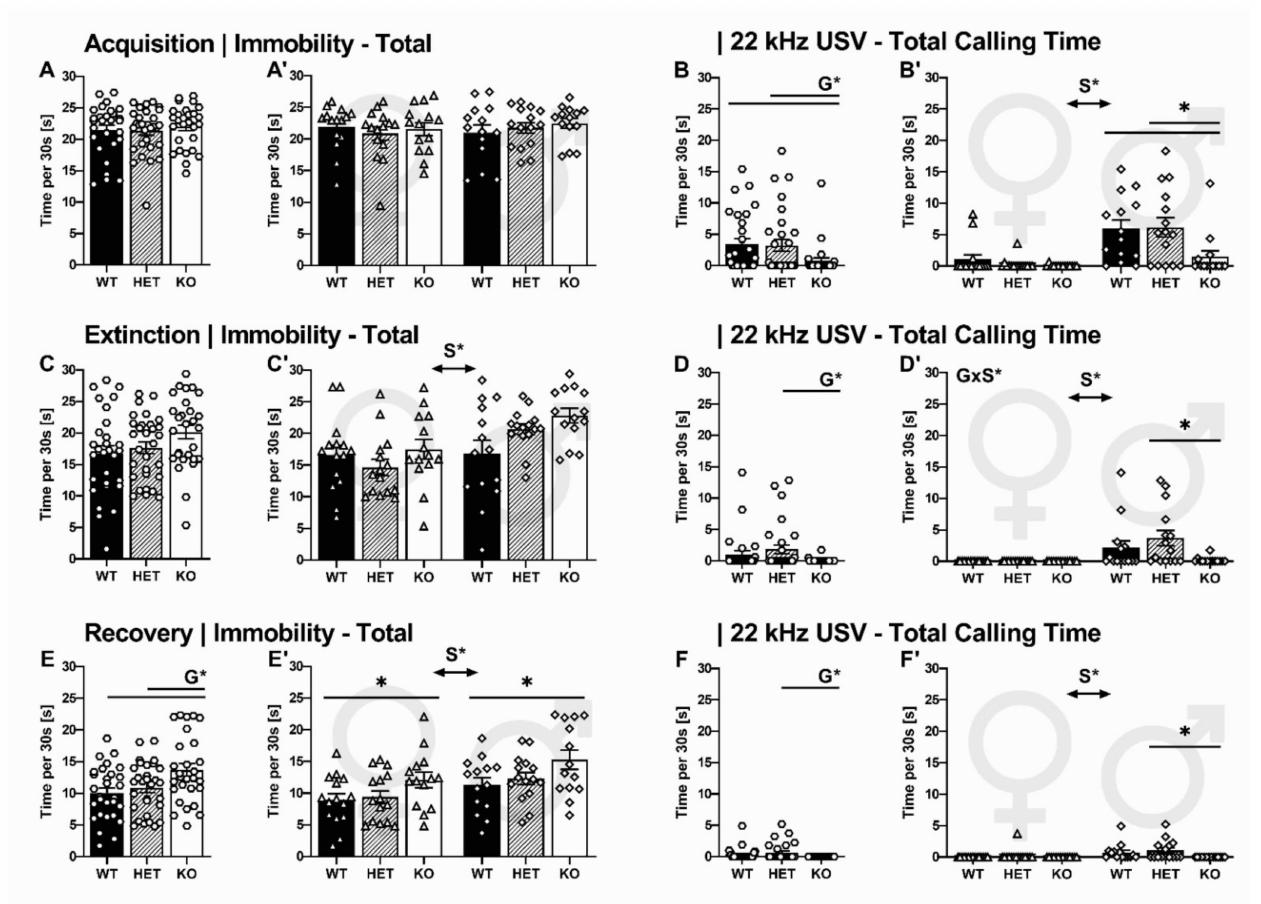
Figure 3. Overall immobility and 22-kHz total calling time. Effects of SERT deficiency on overall immobility and 22-kHz USV total calling time during acquisition ( A , B ), extinction ( C , D ), and recovery ( E , F ). Time spent immobile is shown for SERT +/+ (black bar), SERT +/ − (striped bar), and SERT − / − (white bar) rats with sexes pooled ( A,C,E ) and separated by sex ( A,C,E ), with females on the left and males on the right side of the panel. Time spent calling 22-kHz USV is shown for rats with sexes pooled (B,D,F) and separated by sex ( B,D,F ), with females on the left and males on the right side of the panel. N = 44 female rats (15 +/+, 15 +/ − , 14 − / − ), N = 43 male rats (14 +/+, 15 +/ − , 14 − / − ). Data are presented as mean ± SEM. G* p < 0.05 effect of genotype, with lines indicating significant post-hoc comparison between genotypes. S* p < 0.05 effect of sex. * p < 0.05 for subgroup